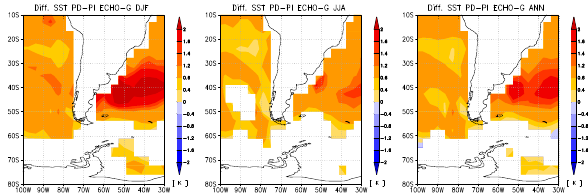
Fig. 6b. Difference maps between the present-day and the pre- Figure 6b : Difference maps between the present-day and the pre-industrial periods for sea industrial periods for sea surface temperatures of the driving surface temperatures of the driving ECHO-G model. left: DJF, middle: JJA, right: annual. ECHO-G model. Left: DJF, middle: JJA, right: annual. Only values Only values statistically significantly different at the 5% level are given (Two-sided t-test). statistically significantly different at the 5% level are given (two- sided